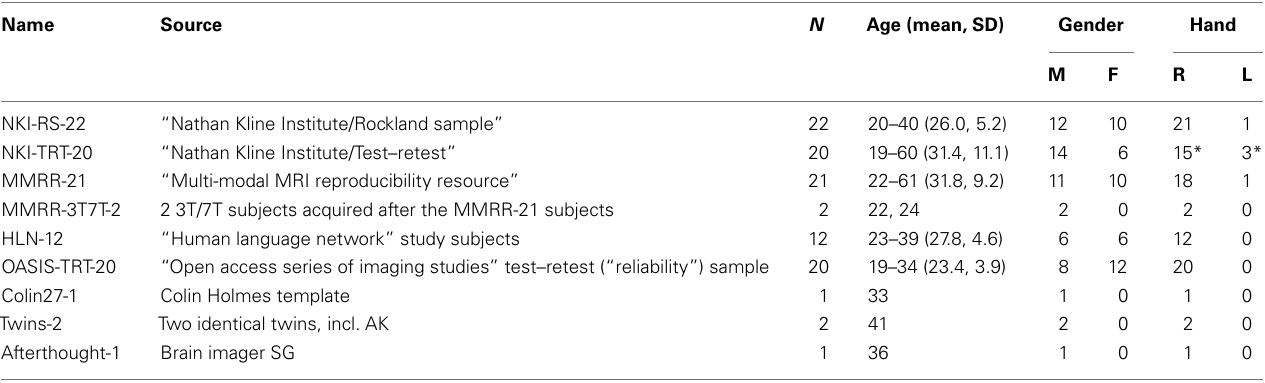
Table 1 | Data sets comprising the Mindboggle-101 labeled data